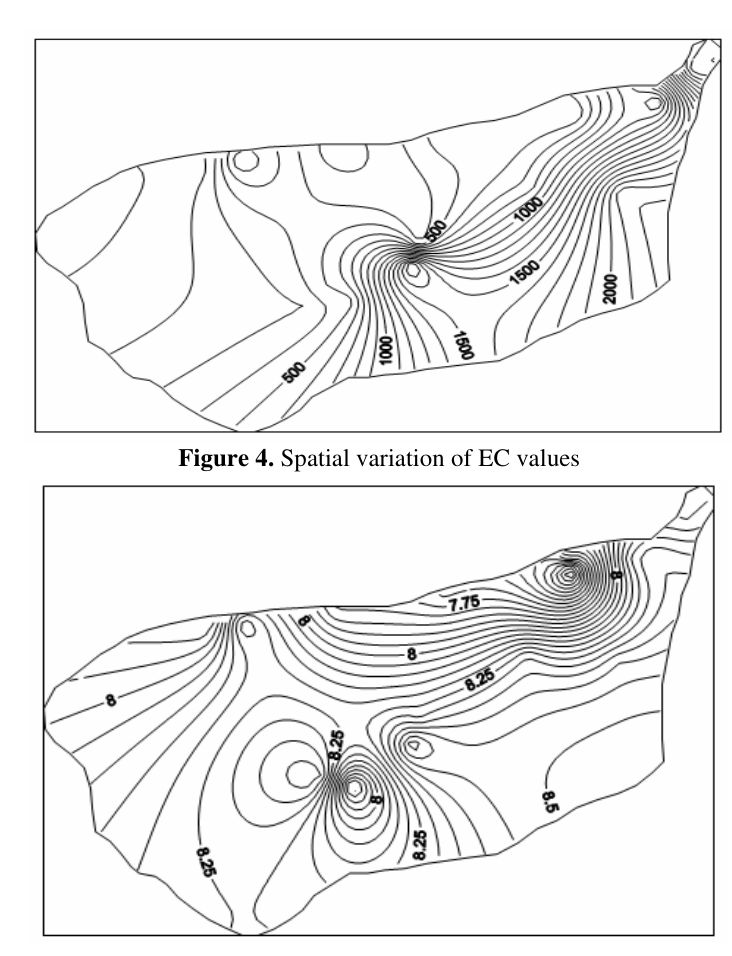
Figure 5. Seasonal variation of pH